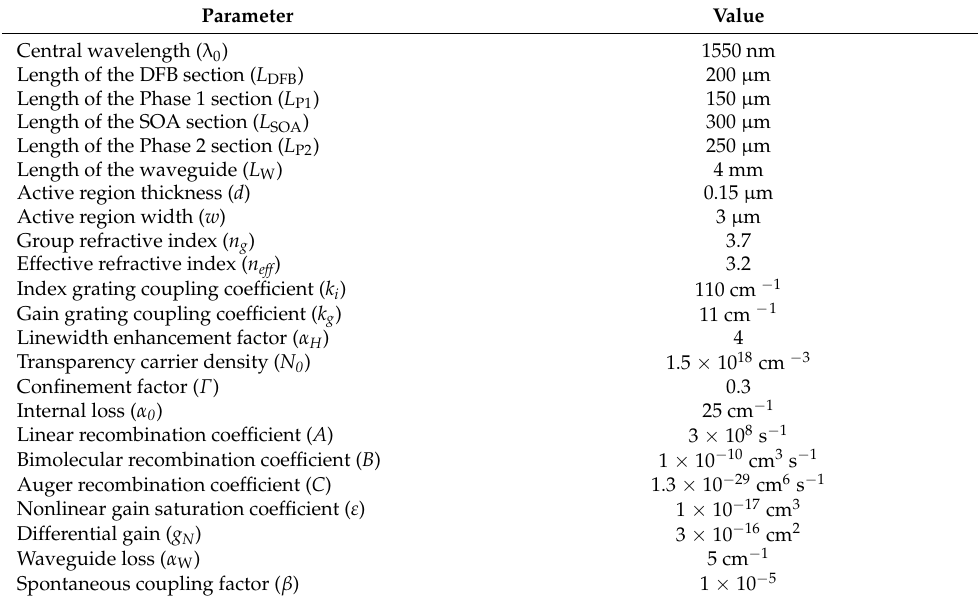
Table 1. Simulation parameters of the